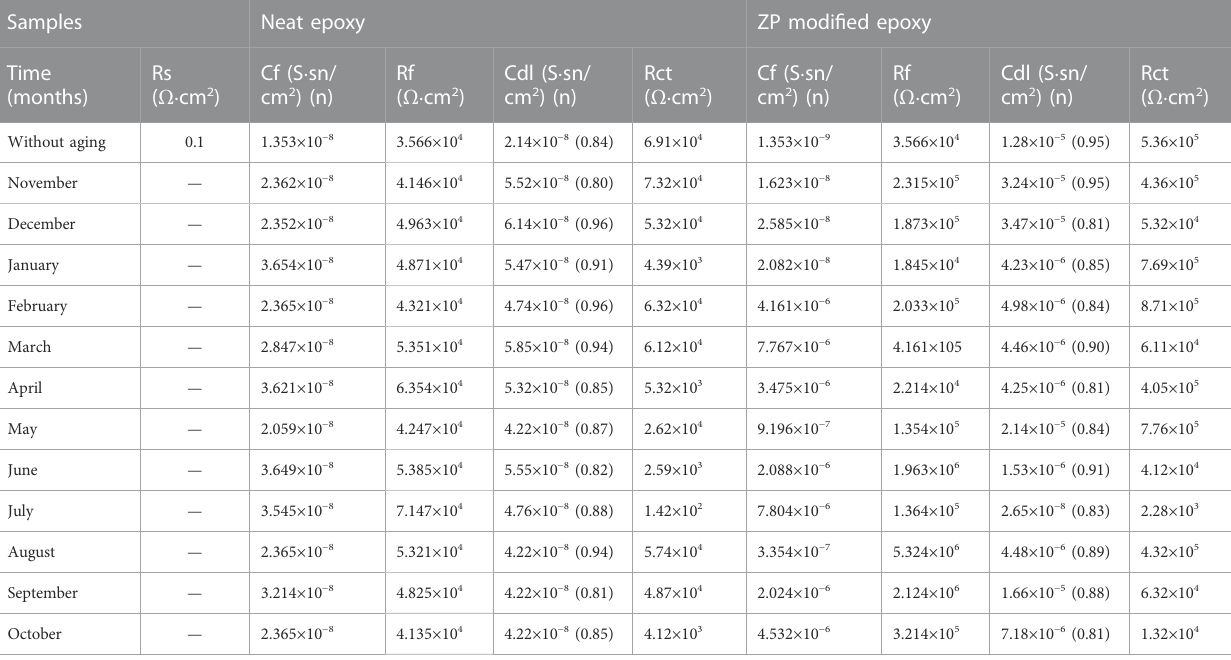
TABLE 5 Electrochemical parameters from EIS equivalent electrical circuit of ZP pigment-modi fi ed epoxy specimens. Samples